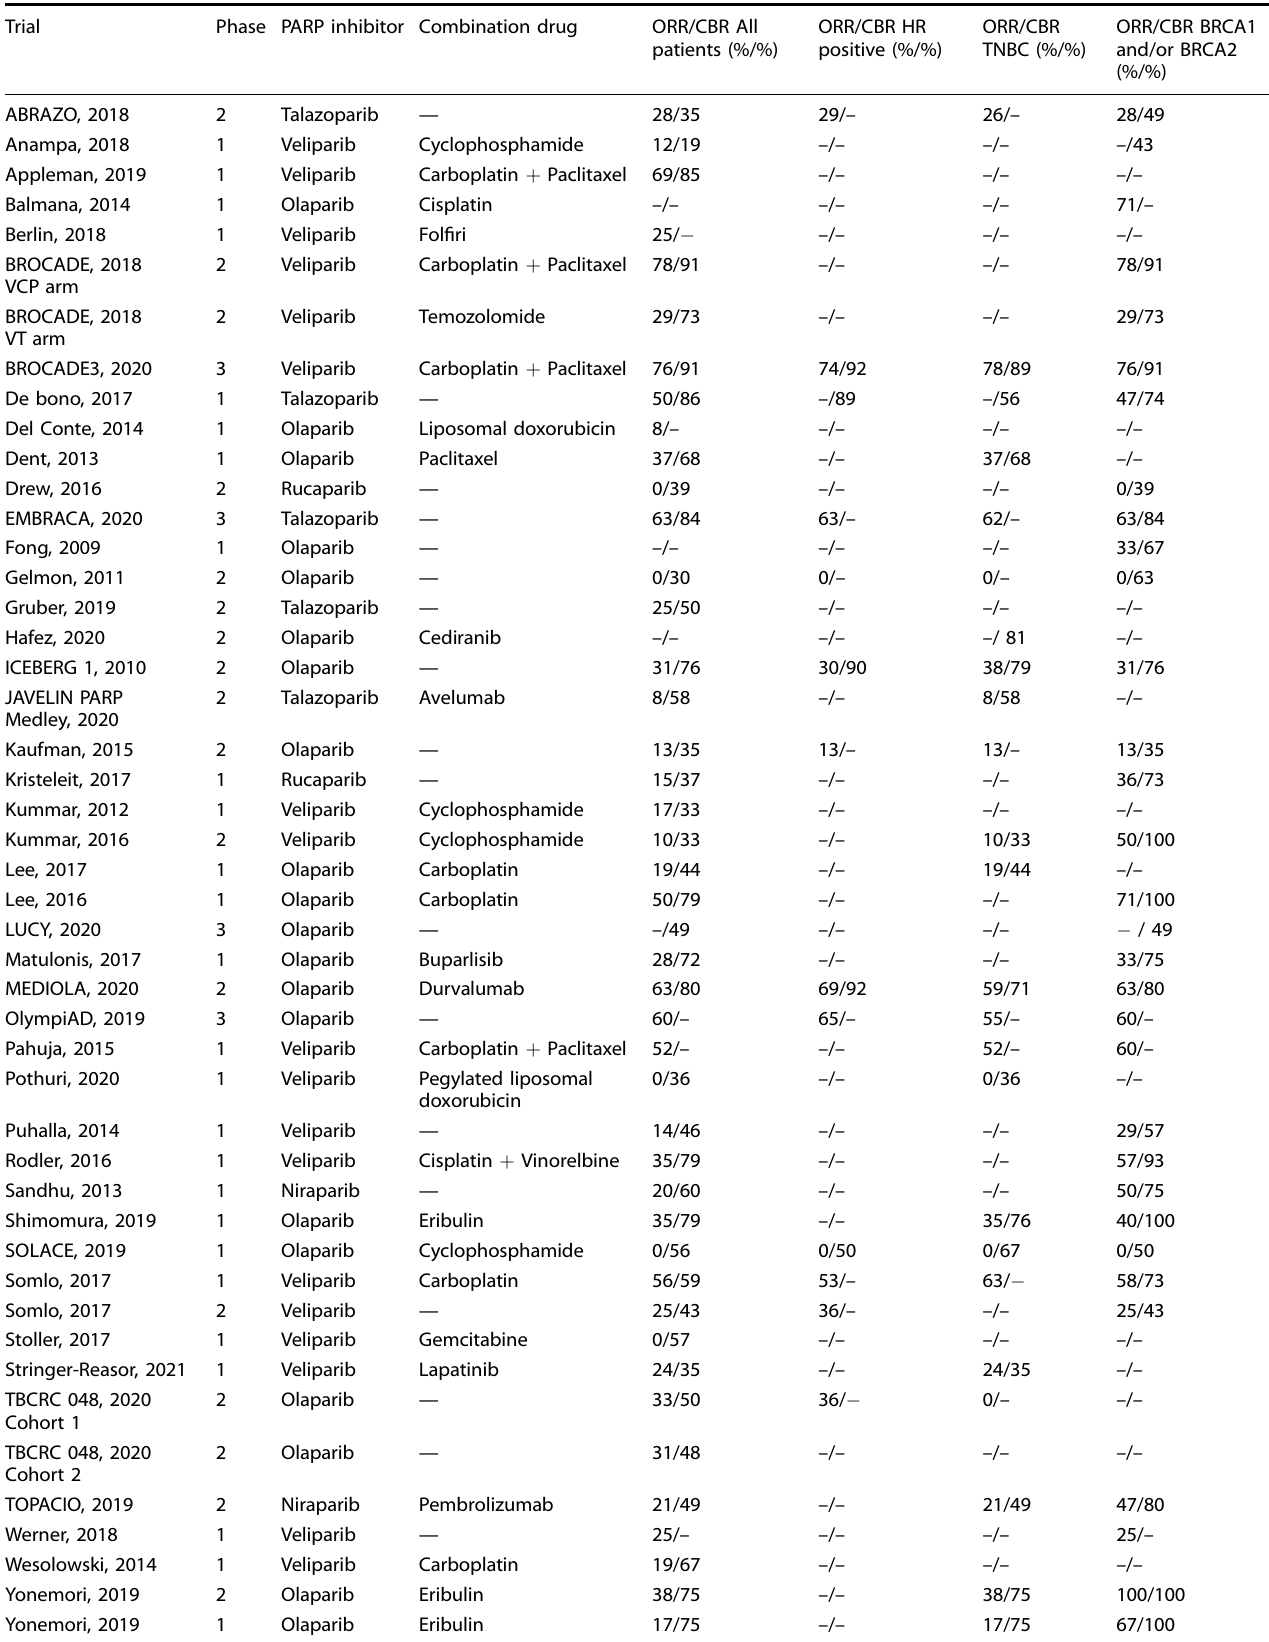
Table 2. Overall response rate and clinical bene fi t rate of all included